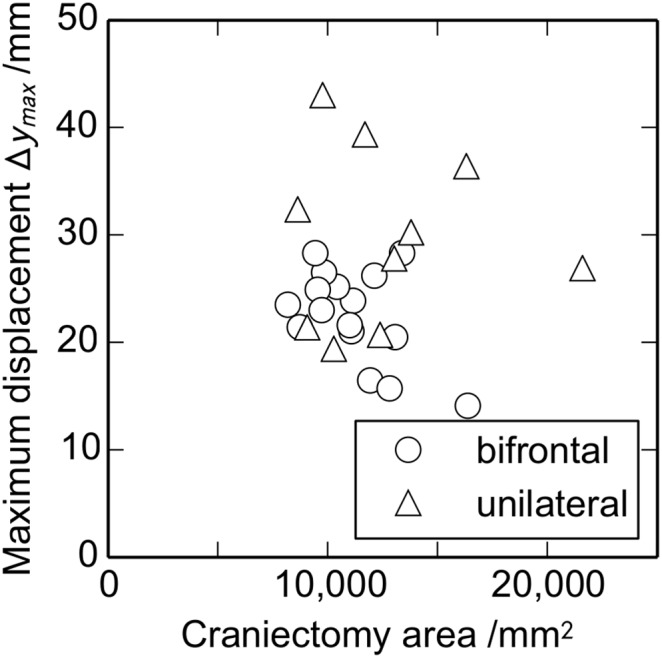
Relationship between the craniectomy area and the maximum displacement Δymax (n (bifrontal) = 16, n (unilateral) = 10).